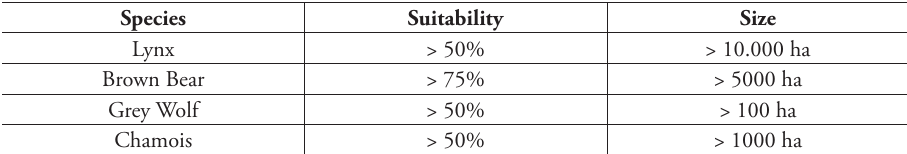
Table 2. Pixels’ suitability and core areas